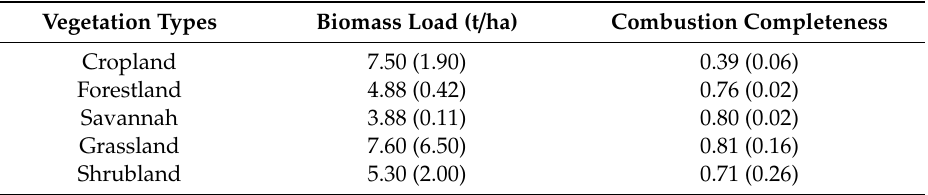
Table 2. Value of the biomass loads and combustion completeness in each vegetation fire (standard error in